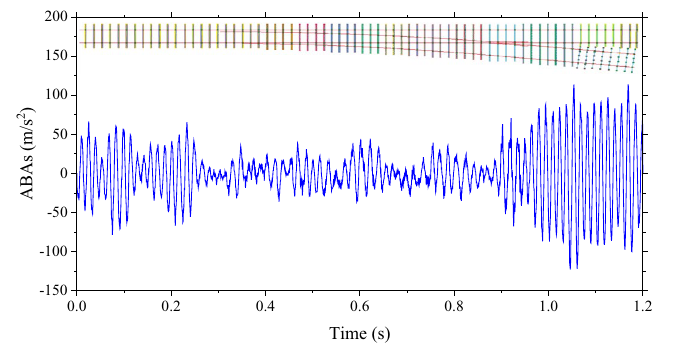
Figure 3. Example of ABAs.